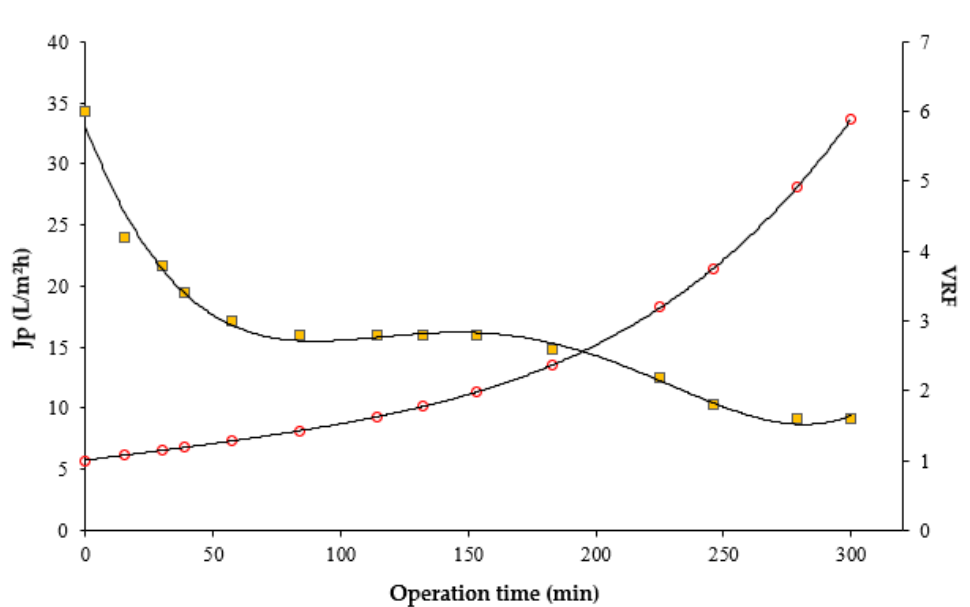
Figure 4. Operating time of the permeate flux and VRF (Operating conditions: PTM = 69 kPa, T = 21 °C, Qf = 77.8 L/h).